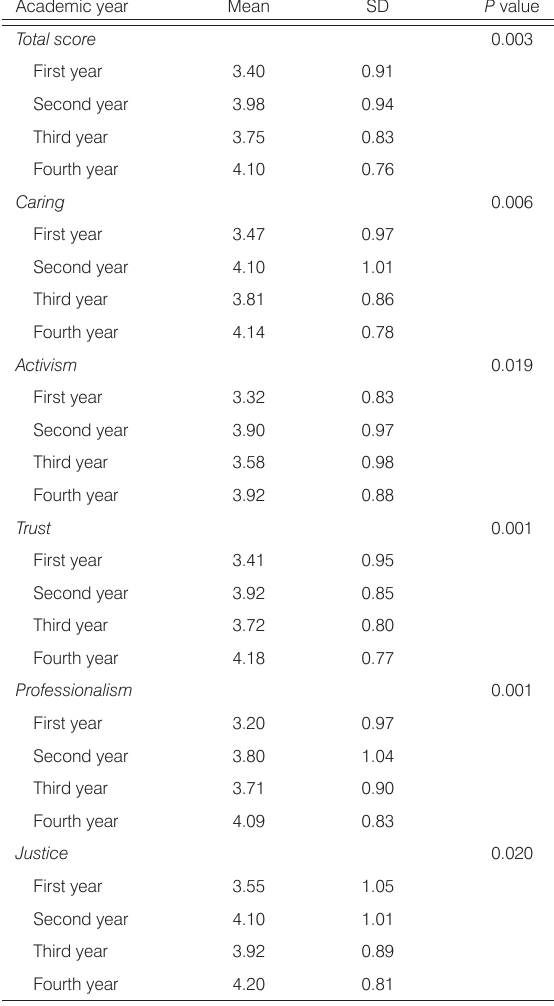
Table 4. Scores of NPVS-R and its domains in relation to the academic